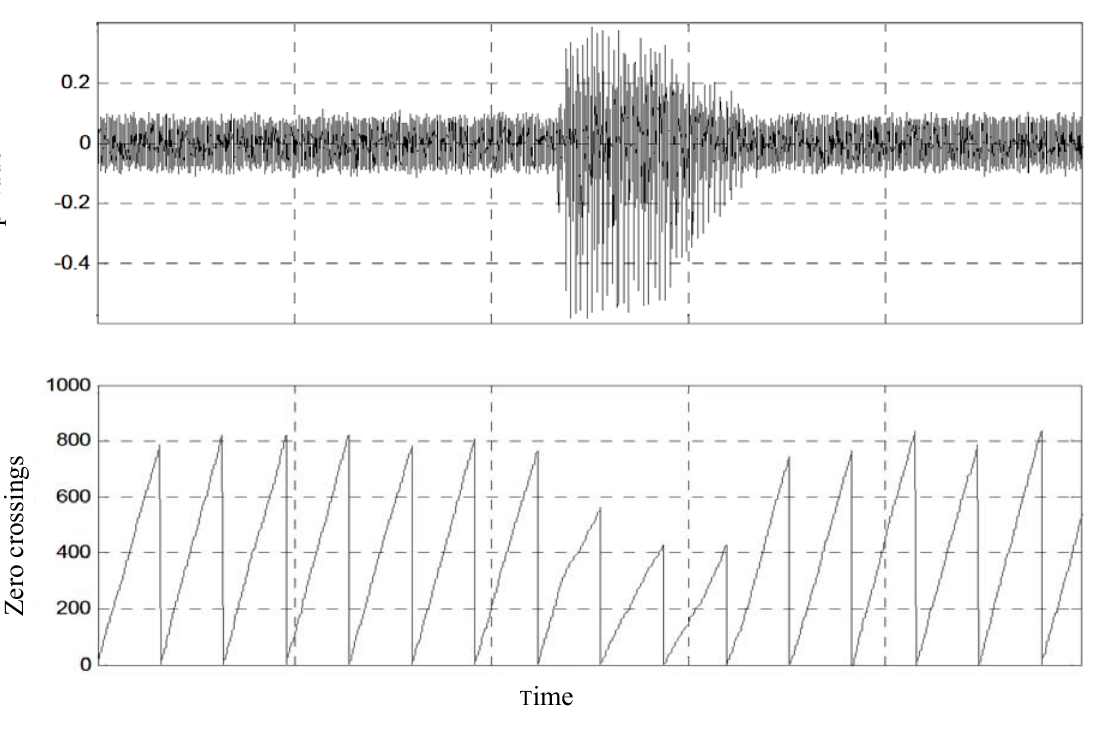
Figure 6. Zero crossing detection of a noisy